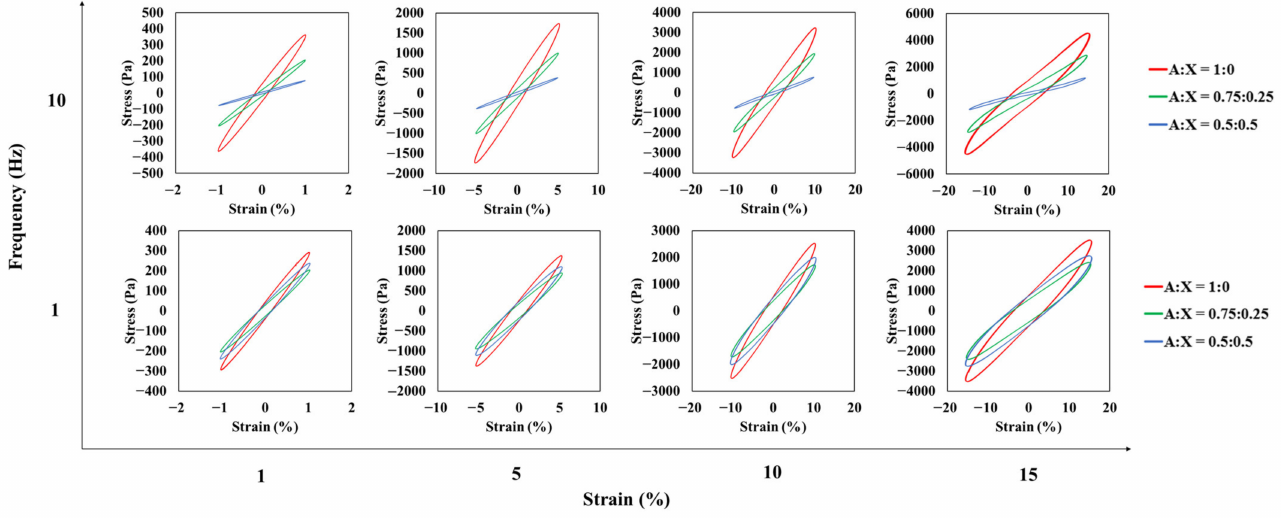
Figure 6. Elastic Lissajous-Bowditch curves for agarose-xanthan gel systems measured at different strains and frequencies.